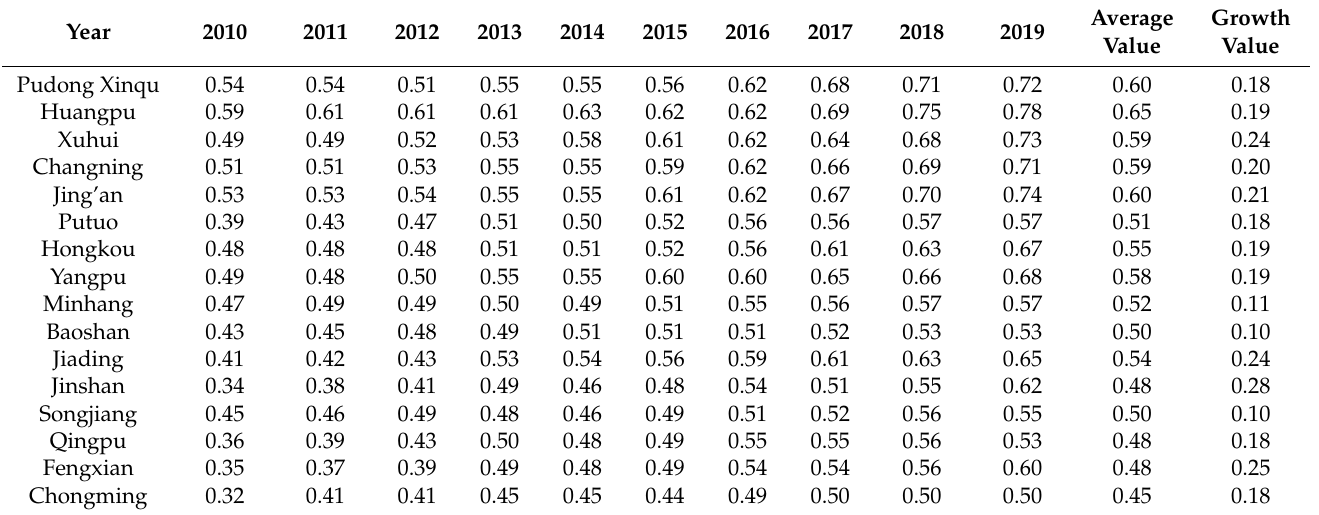
Table 4. Regional vitality of 16 regions in